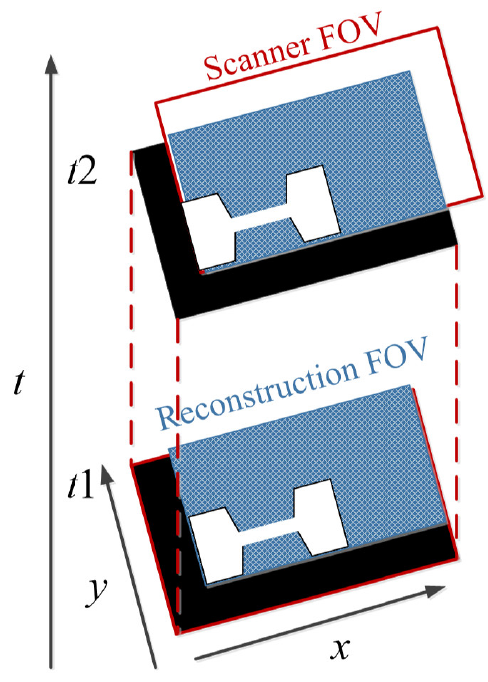
Figure 4. The schematic diagram of 2D joint image reconstruction.